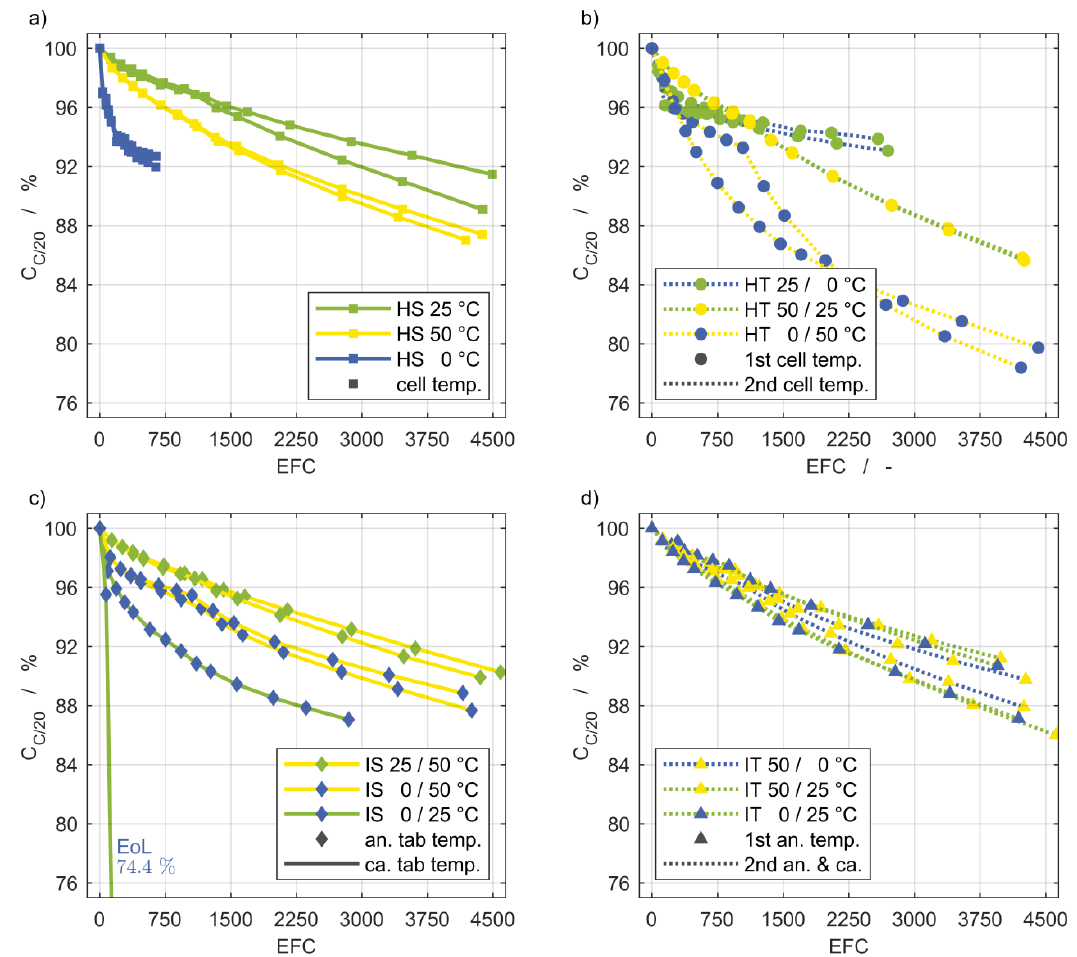
Figure 7. Discharge capacity fade of the setups shown as flow diagrams in Figure 2. The markers indicate intermediate cell characterizations and anode tab temperature of inhomogeneous setups. The homogeneous stationary and transient setups are shown in ( a ) and ( b ). The inhomogeneous stationary und transient setups are shown in ( c ) and ( d ). The EoL capacity of one cell of the inhomogeneous, steady (IS) 0/25 °C setup is outside the scale and therefore noted separately. EFC: Equivalent full cycle.